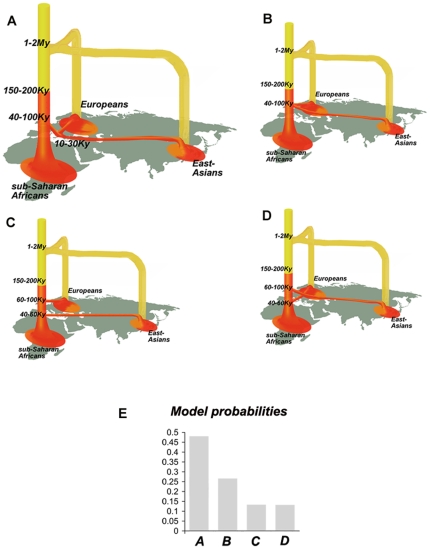
Models of recent African origin involving different dispersal scenarios.(A) General RAOEB model best fitting the data, with parameter ranges given in Table 2. This model assumes a single out-of-Africa dispersal followed by the European and East-Asian split. (B) RAOEB model involving two independent, concomitant dispersals out of Africa, each giving rise to Europeans and East-Asians. (C) RAOEB model involving two independent dispersals out of Africa occurring at different times, the earlier giving rise to Europeans. (D) RAOEB model involving two independent dispersals out of Africa occurring at different times, the earlier giving rise to East Asians. For models B–D, the ranges of parameters are the same as those given in Table 2. The alternative dispersal model B (two independent dispersals at the same time) was performed using a split of the two non Africans populations concomitant with the time of out-of-Africa exodus (TOoA) simulated with the same prior reported in Table 2. The two alternative dispersal models C and D (two independent dispersals at different times) were simulated using times for the first out-of-Africa exodus drawn from the first half of the prior distribution of TOoA (Table 2), while times for the second out-of-Africa exodus were drawn from the second half of the prior distribution of TOoA. (E) Posterior probability estimated for the 4 possible dispersal models represented in A, B, C, and D.